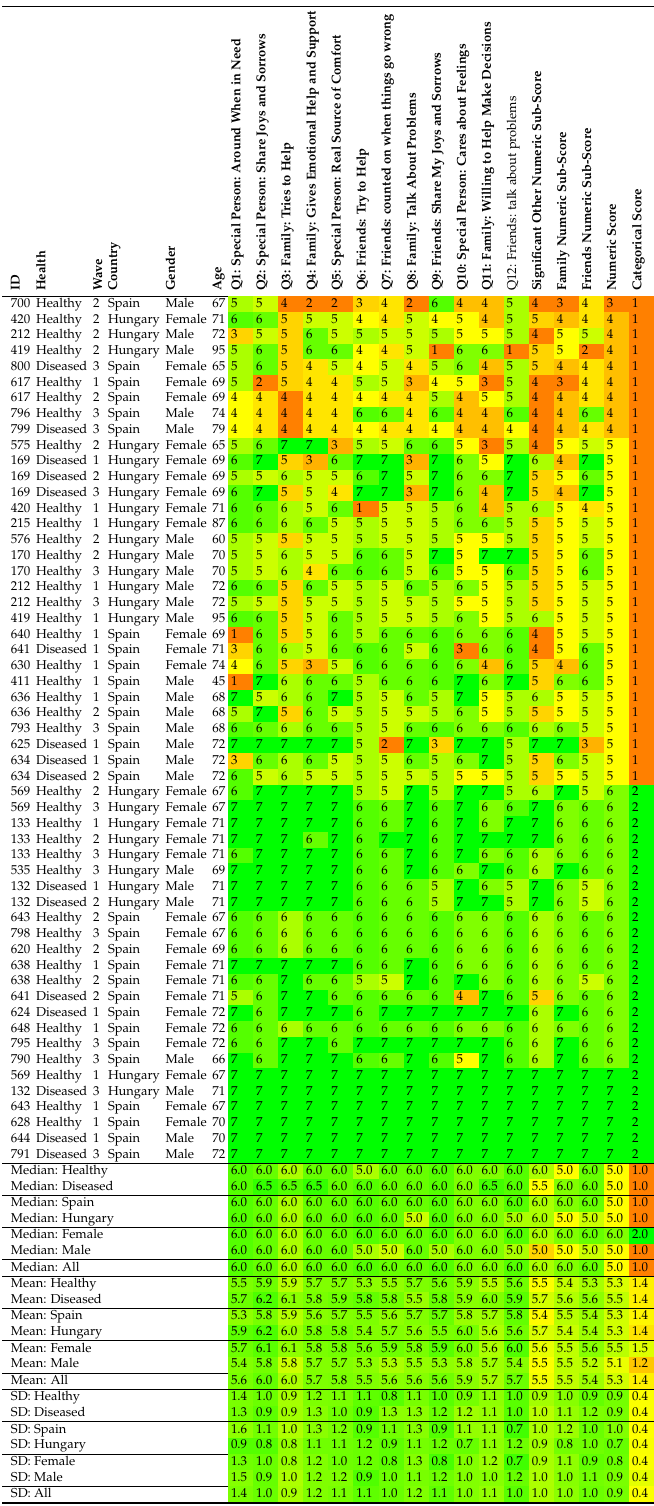
Color coding: from orange (worse outcome relative to others) to yellow to green (better outcome). Men self-reported lower social support than women, as observed in the median (mean numeric scores of 5.0 (5.2 1.0) vs. 6.0 (5.5 0.8) as well as median categorical score drop from high ± ± to moderate. Males self-reported less social support from the friends at means 5.2 vs. 5.6, less